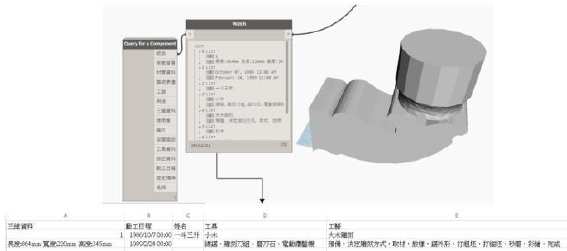
Figure 9. The browsing result of a building component in